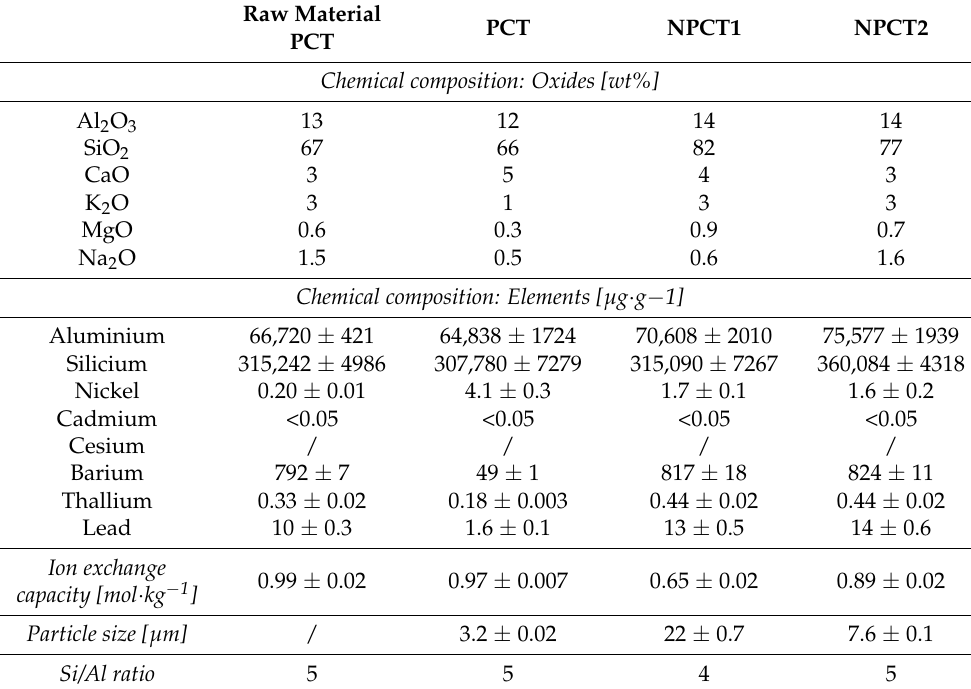
Table 2. Chemical characterization of the sorbent